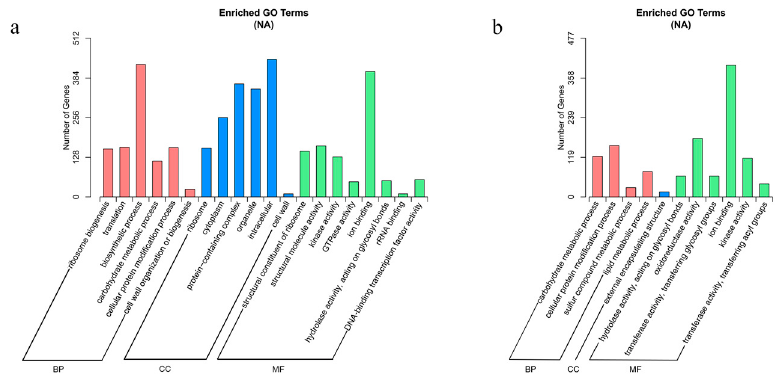
Figure 6. Enriched GO terms based on DEGs identified in leaves and petioles under salt treatment. ( a ) Enriched GO terms in leaves. ( b ) Enriched GO terms in petioles. ( a ) Enriched GO terms in leaves. ( b ) Enriched GO terms in